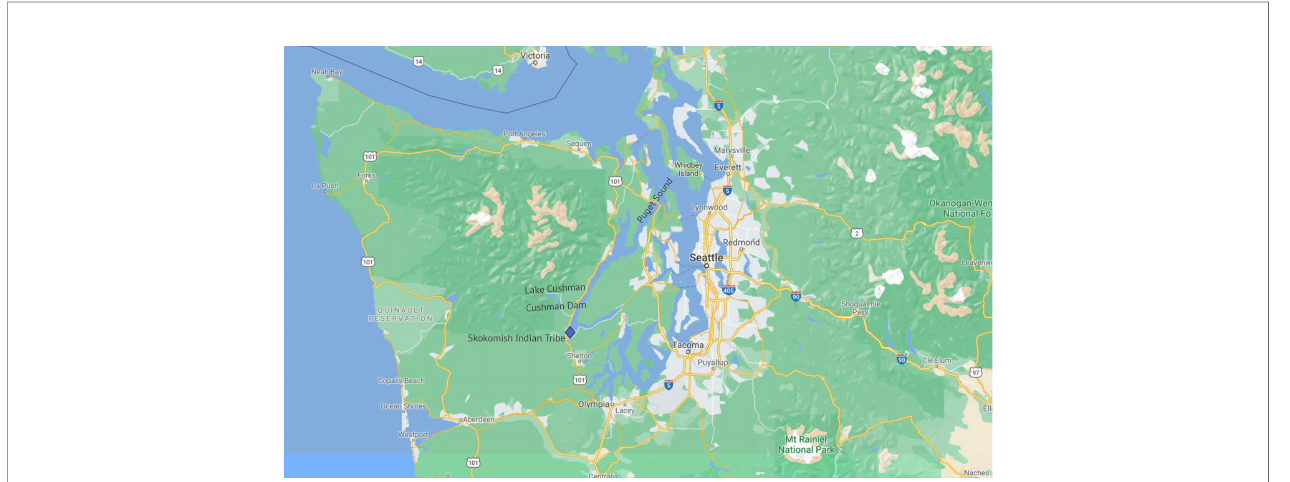
FIGURE 1 | The Olympic Peninsula Region (Source: Google